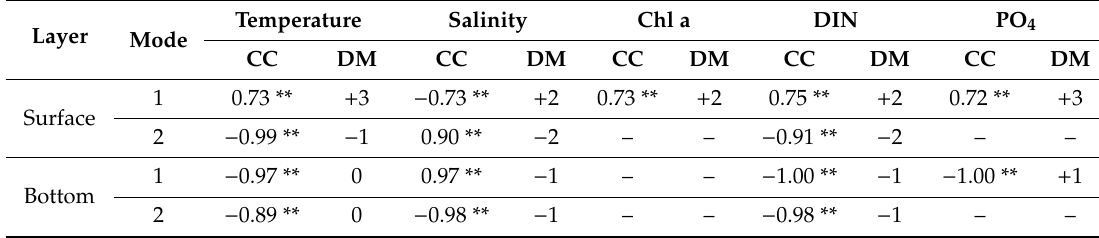
Table 5. Delayed correlation coe ffi cients between the fitting sequences of RPCs of DO and those of other environmental